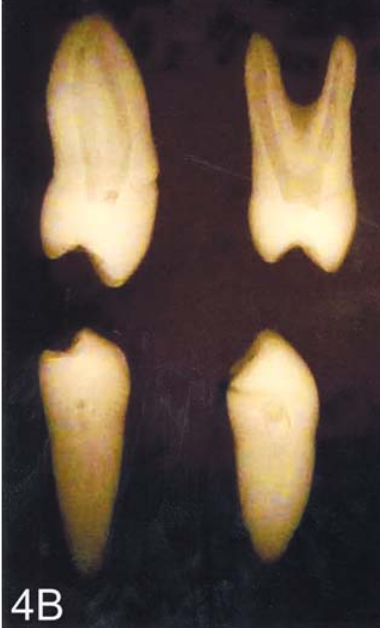
FIGURE 4B- Radiographic image of cloudy resin premolars